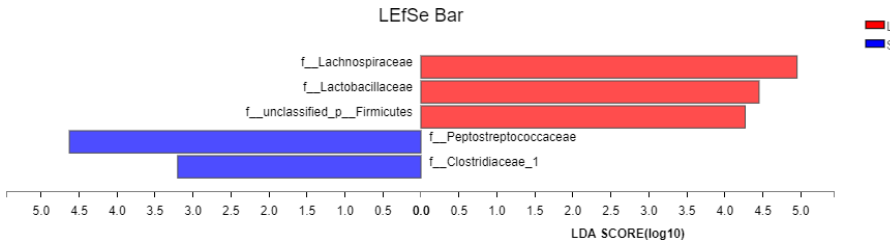
Figure 7. Lefse analysis of intestinal microflora abundance in group LS.